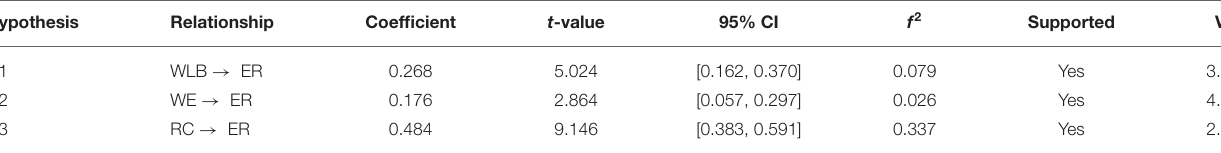
TABLE 4 | Results of hypothesis testing.